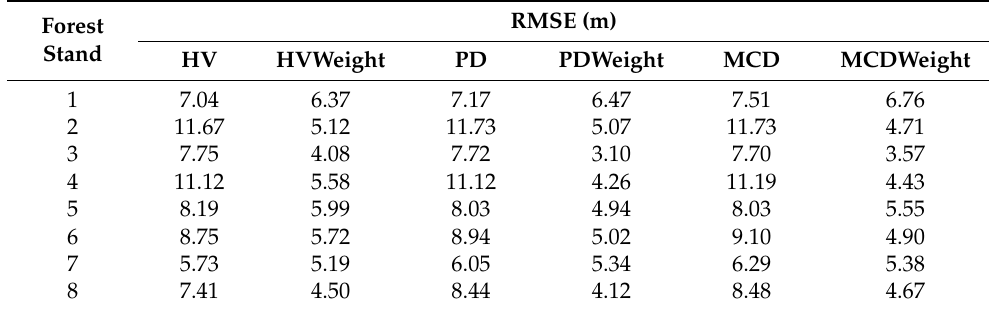
Table 4. The RMSE of various methods for the corresponding 8 forest stands with real data. Forest